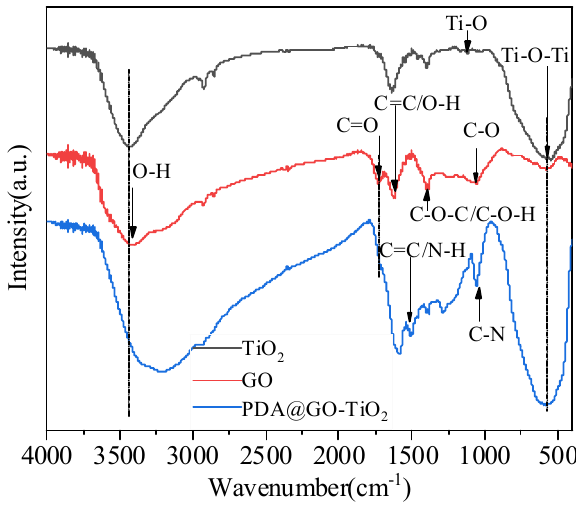
Figure 3. Fourier transform infrared spectrum of nano-PDA@GO-TiO 2 composites, graphene oxide (GO), and nano-TiO 2.